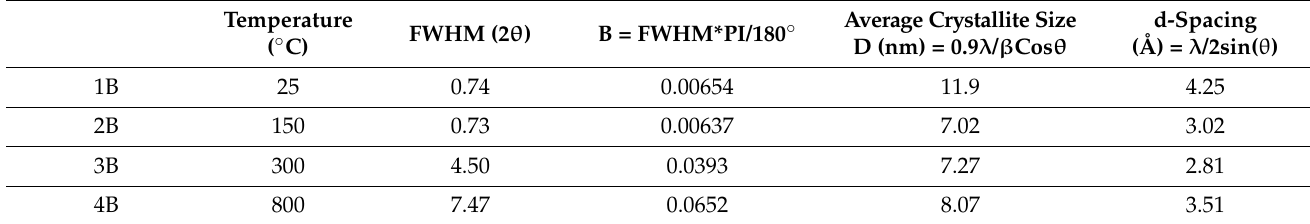
Table 3. Particle size parameters for Goethite and Hematite